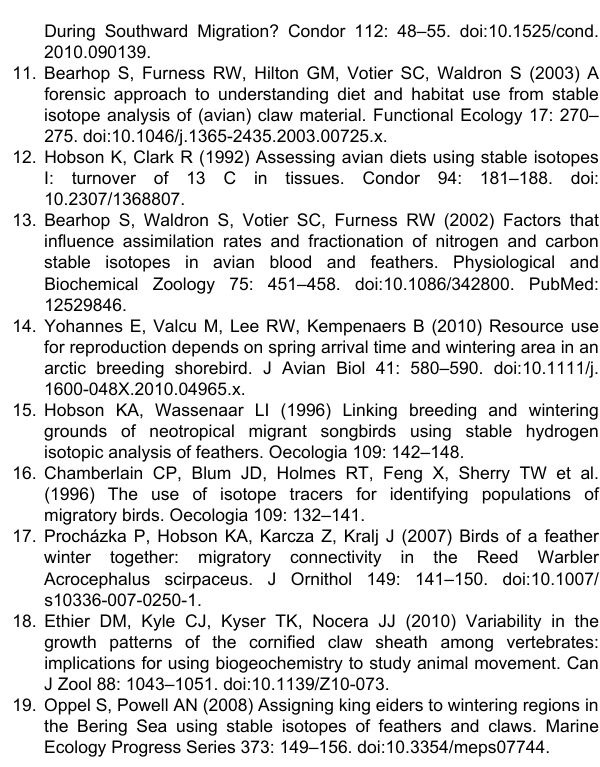
Table S1. Results for t-tests and Wilcoxon rank-sum tests. (PDF) Table S2. Mean difference of isotope values for flightless duckling feathers and claw